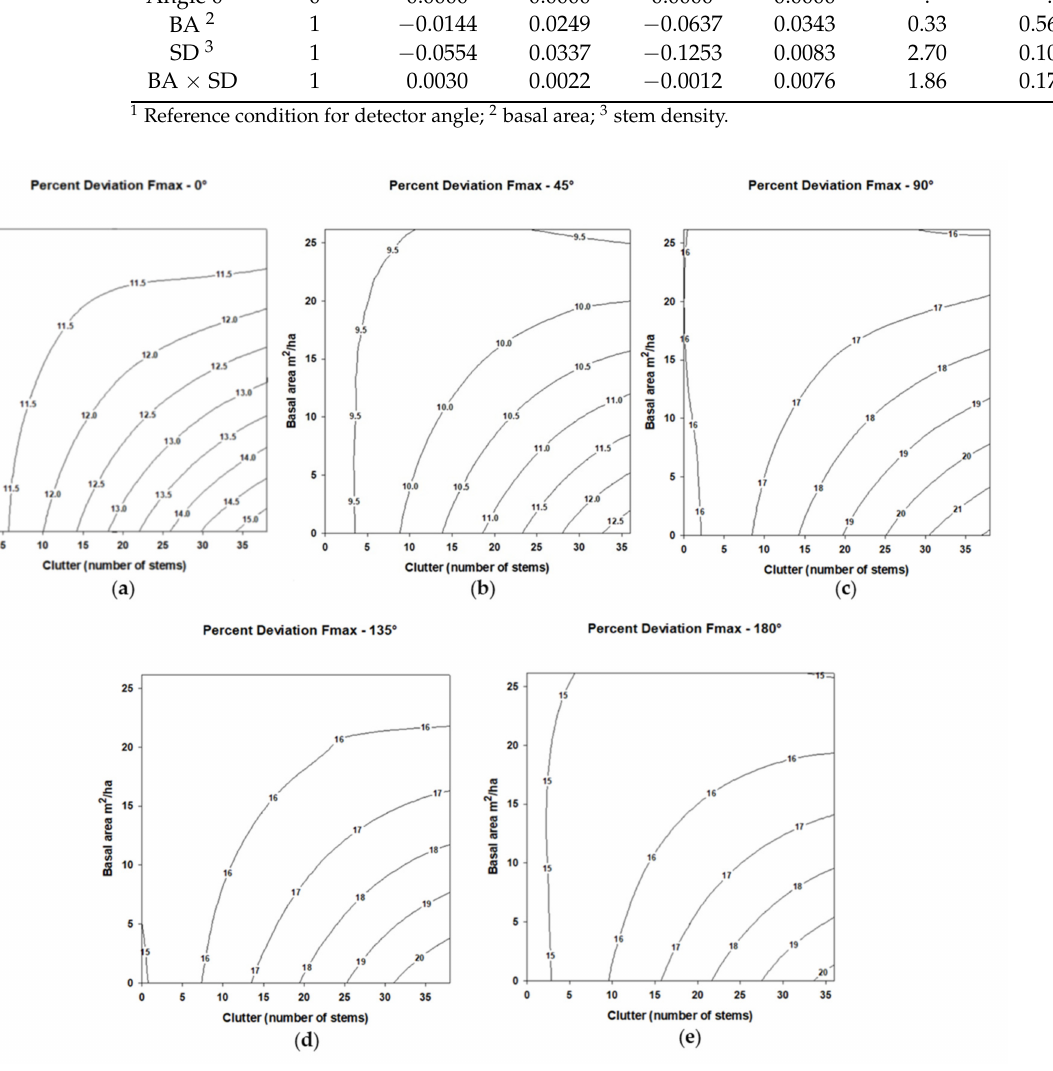
Figure 3. Contour graph for generalized linear model results of synthetic bat echolocation playback response within an anechoic chamber displaying the percent deviation on the maximum frequency (Fmax) call parameter in relation to stem density (stem count) and basal area (m 2 /ha) for detector angles ( a ) 0 ◦ , ( b ) 45 ◦ , ( c ) 90 ◦ , ( d ) 135 ◦ , and ( e ) 180 ◦ , Blacksburg, VA, USA, 2016 (see text for